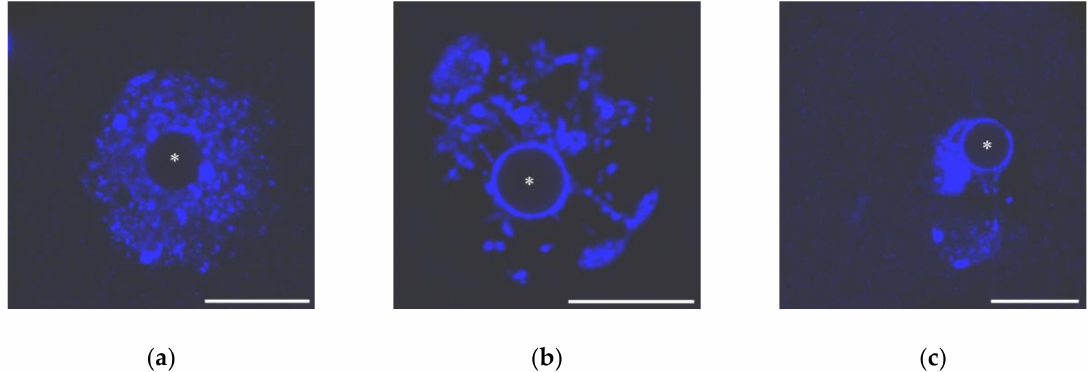
Figure 1. The nuclei of growing mouse oocytes, demonstrating di ff erent chromatin organization as viewed after DAPI staining: ( a ) NSN; ( b ) early SN; a heterochromatin “ring” around unstained nucleolus-like body appears; and ( c ) late SN; chromatin is assembled in a more compact mass (karyosphere). Asterisks indicate nucleolus-like bodies. Scale bars represent 20 µ m.